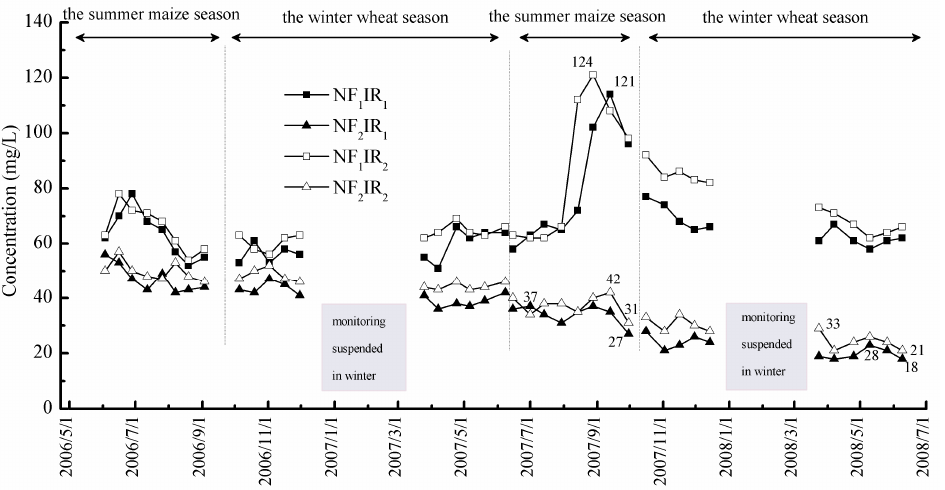
Figure 5. Nitrate concentrations of soil solutions at a depth of 2.0 m under different N and irrigation management practices.